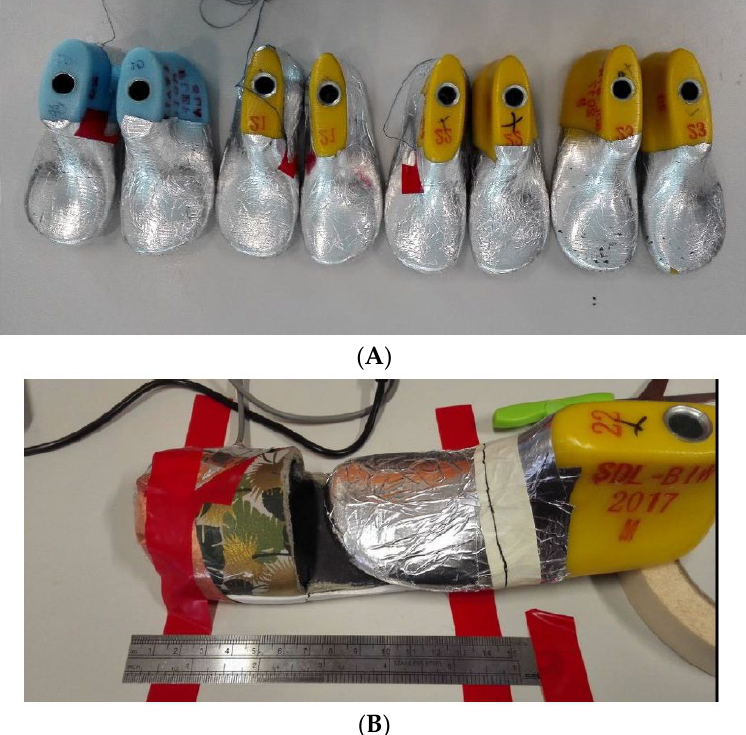
Figure 9. ( A ) Foot phantom, showing different sizes (showing sizes 20–23, left to right), ( B ) Test setup.